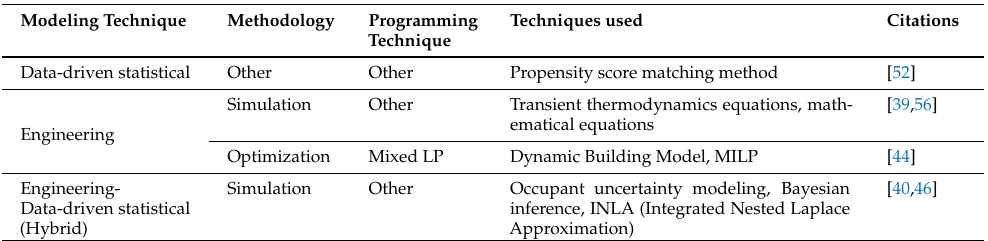
Table 11. Techniques and Methodologies used in bottom-up energy models that support energy efficiency policy design—Residential